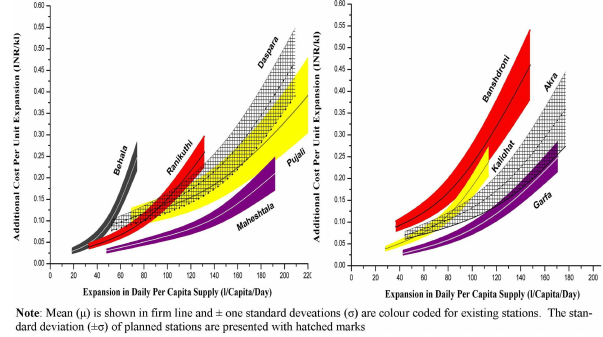
Figure 3. Capacity-Cost curves for booster pumping